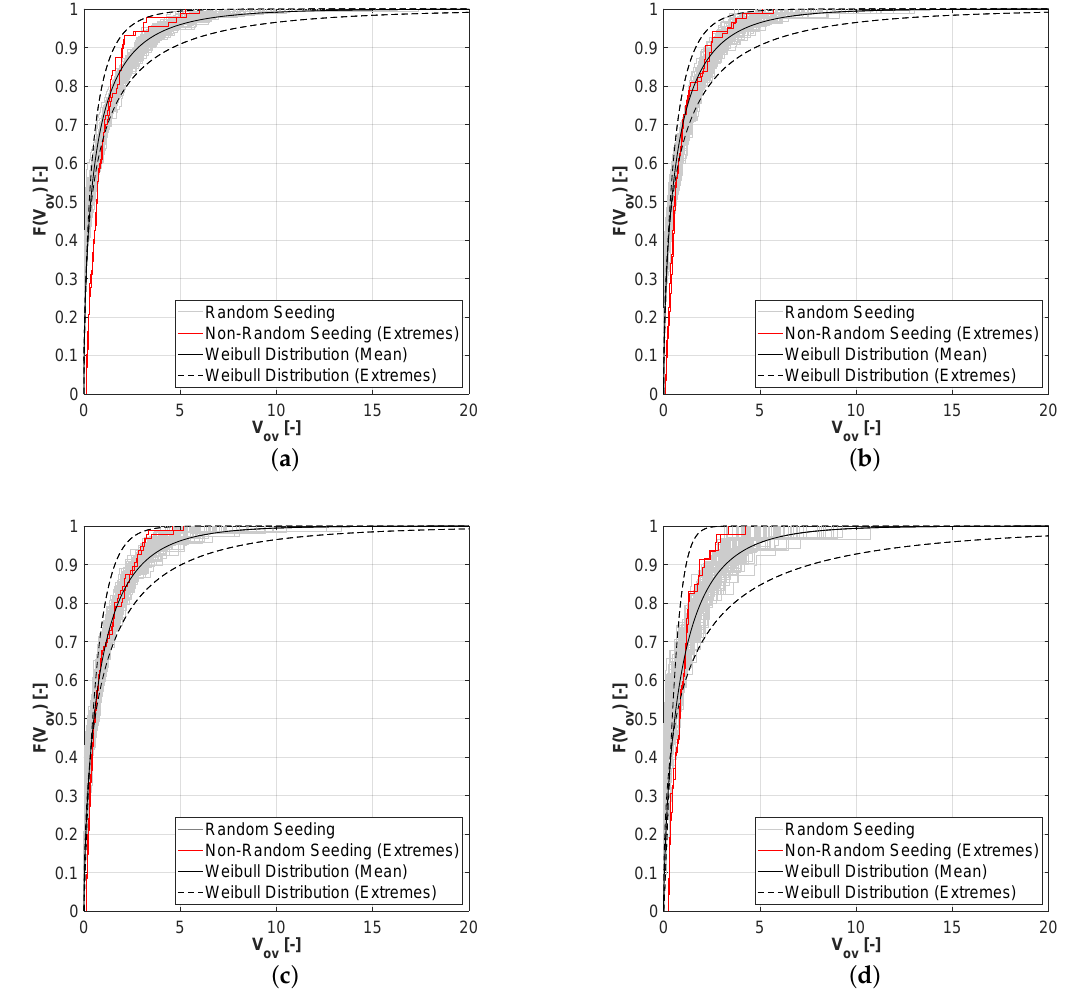
Figure 11. Cumulative density functions showing distributions of individual overtopping volumes of vertical wall.( a ) TS01-VW; ( b ) TS07-VW; ( c ) TS05-VW; ( d )